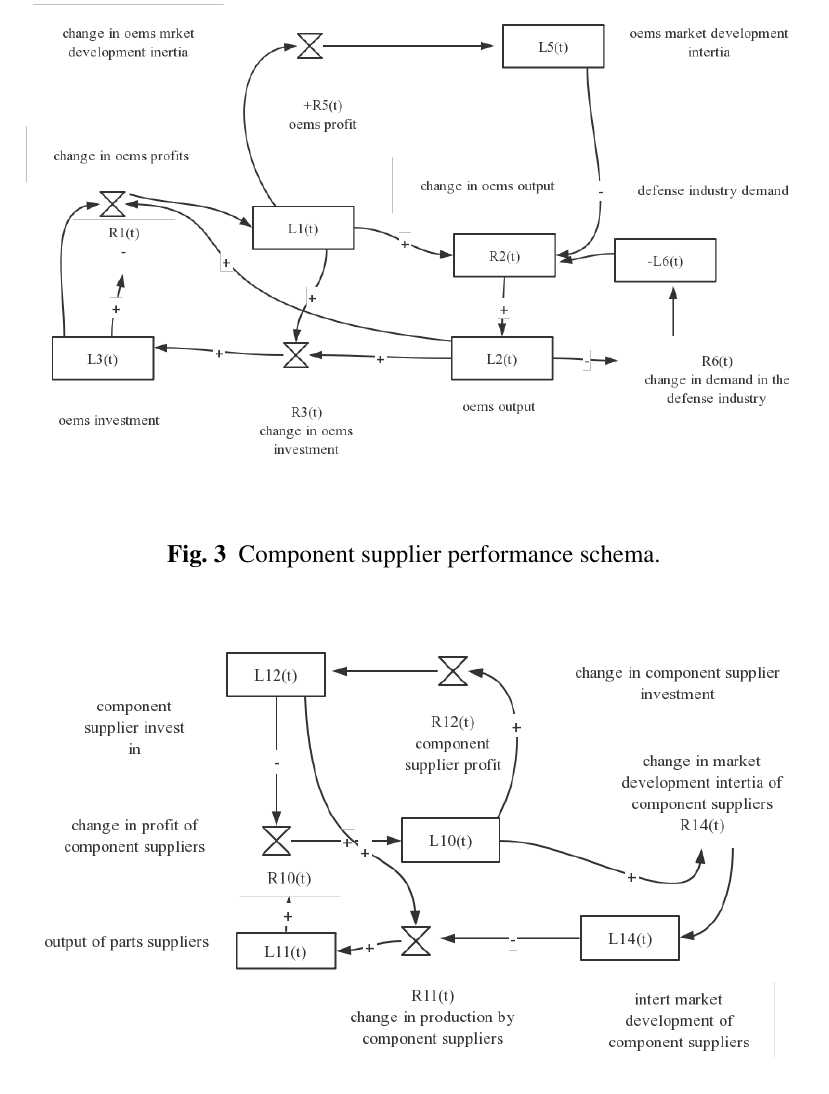
Fig. 4 Performance Schema of Defense Military Industry